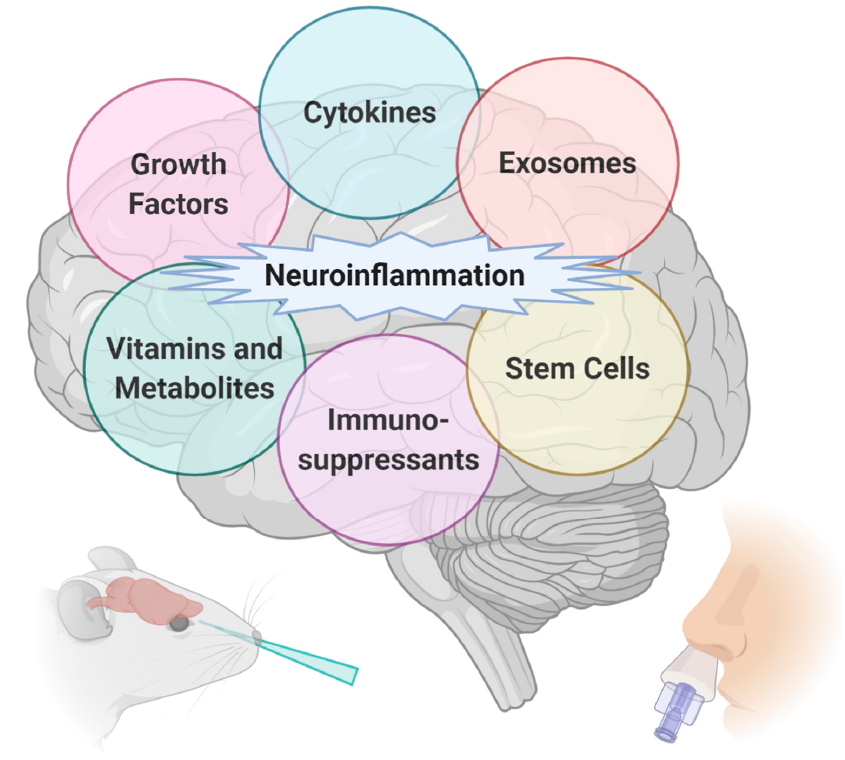
Figure 1. Intranasal (IN) delivery of therapeutics aids in targeting neuroinflammation in many different central nervous system (CNS) diseases such as Alzheimer’s disease, Parkinson’s disease, multiple sclerosis, stroke, and traumatic brain injuries. Generated with